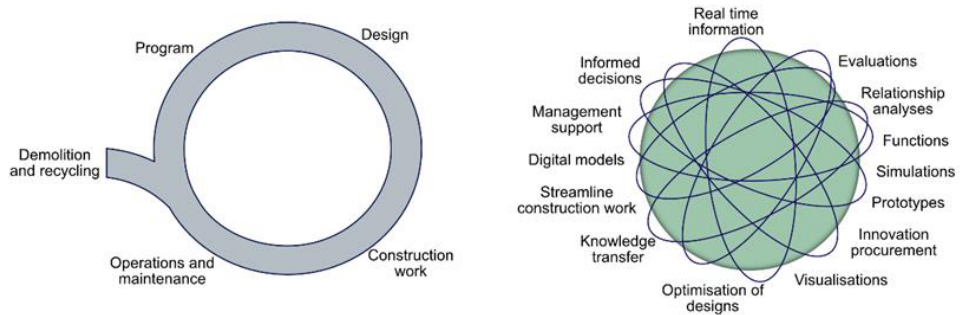
Figure 2. Illustration of building information compared to a data lifecycle perspective. Table 1. The connection between UN Sustainability Development Goals [40] and informed configuration decisions based on data.